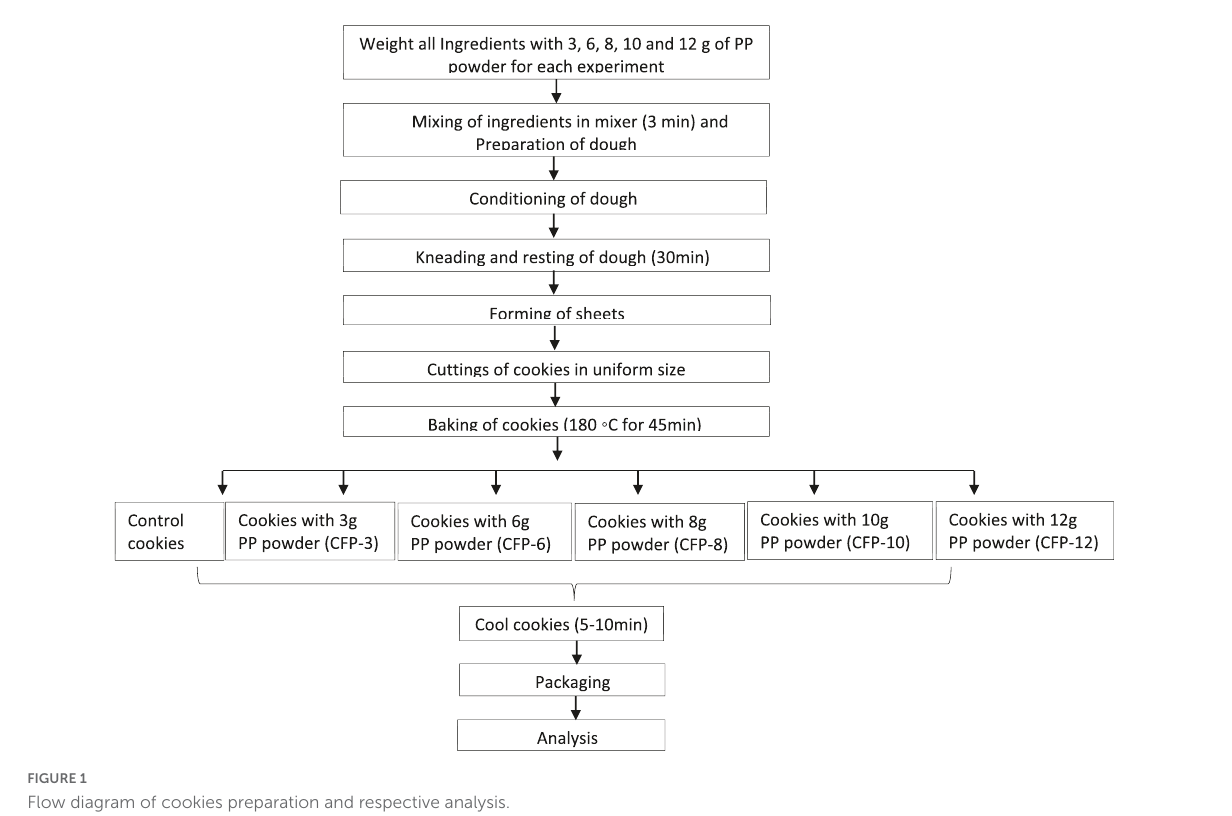
FIGURE1 Flow diagram of cookies preparation and respective analysis.